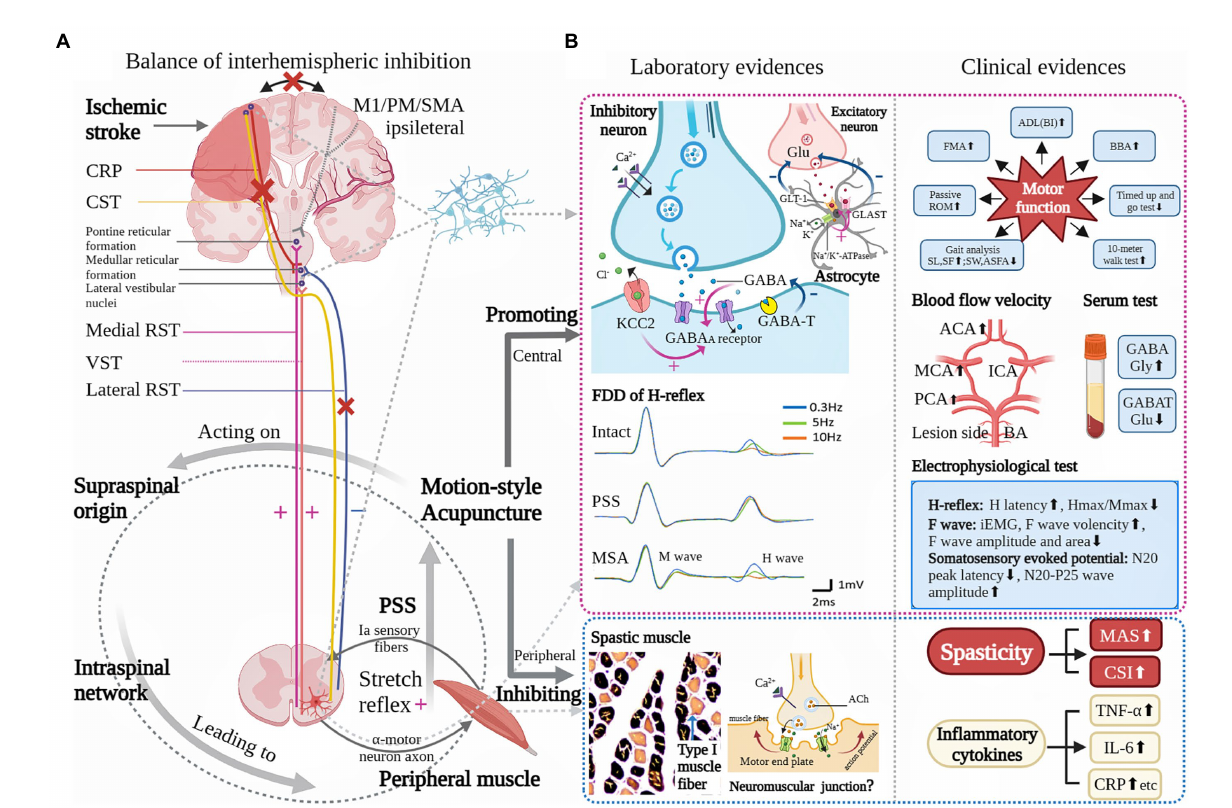
FIGURE 1 Underlying pathophysiology of poststroke spasticity (PSS) and role of motion-style acupuncture (MSA) for PSS. (A) is modified from Li et al. (2) showing that the possible primary mechanism for a loss of inhibitory control after a stroke is an UMN lesion while the secondary factors are altered intraspinal network processing and peripheral muscular changes. (B) Based on current clinical and laboratory evidences, the possible role of MSA for PSS is mainly reflected in two aspects: one is its modulation on the CNS, the other peripheral muscle. Central modulation presents relative neuroprotective effect (improvement of blood perfusion and inhibition of inflammatory response), regulation of balance between excitatory and inhibitory neurotransmitters, functional improvement of sensorimotor pathway, and inhibition of spinal stretch reflex. Peripheral muscle adjustment includes decreased proportion of type 1 muscle fiber. ACA: anterior cerebral artery, Ach: acetylcholine, ADL: activity of daily life, ASFA: affected side foot angle, BA: basilar artery, BBA: Brunel balance assessment, BI: Barthel Index, CRP: C-reactive protein, CSI: clinical spasticity index, CST: cerebral-spinal tract, FDD: